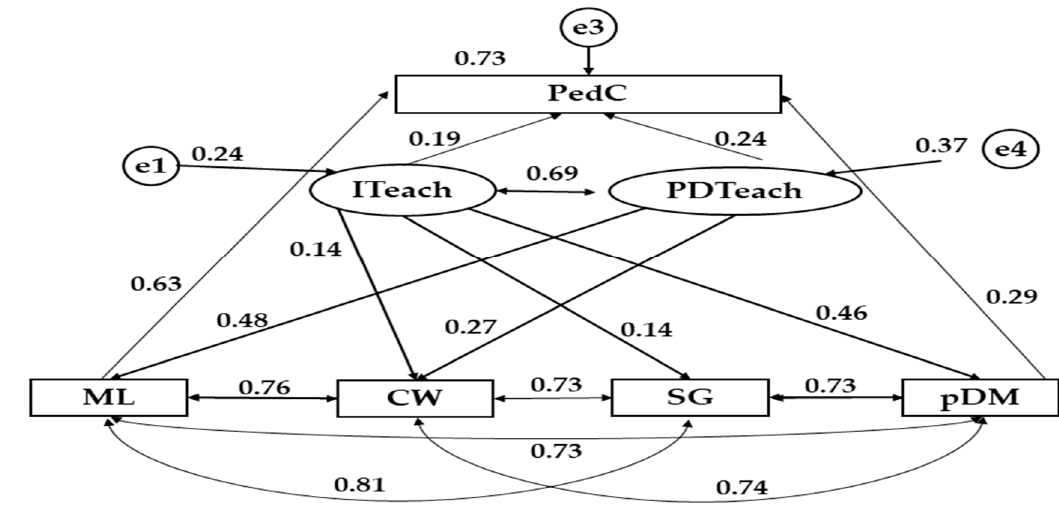
Figure 1. Theoretical model. Note: ML, management leadership; CW, collaborative working, SG, shared goals; pDM, participation in decision making; ITeach, involvement of teaching staff; PDTeach, professional development of teachers; PedC, pedagogical coordination.